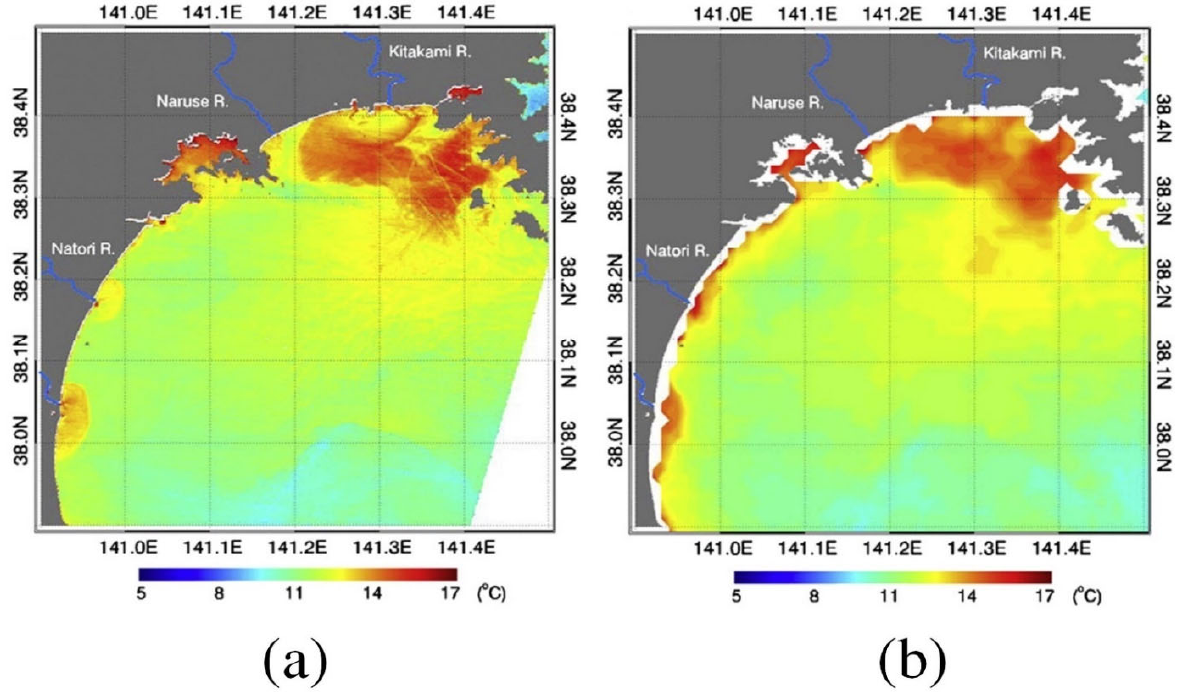
Figure 6. SST maps at 01 UT on 2 May 2003 generated from ( a ) ASTER image with 90 m spatial resolution and ( b ) MODIS data with 1 km spatial resolution [100].